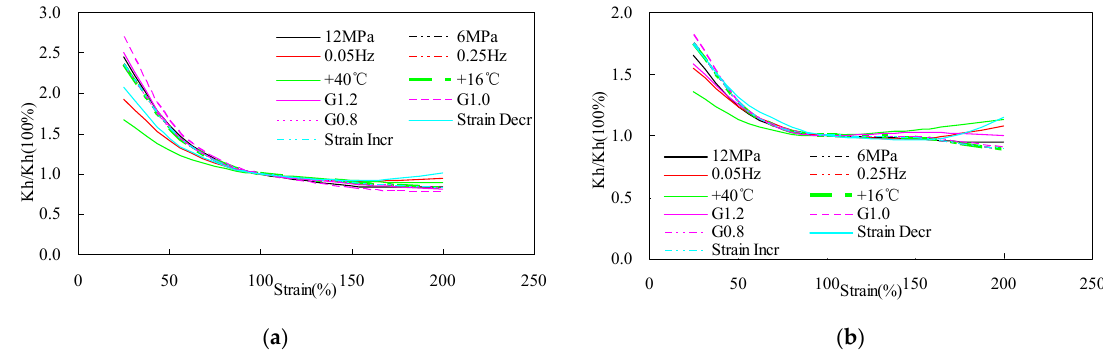
Figure 7. The mechanic properties K h of bearings under different conditions: ( a ) LRB; ( b ) SHDR.